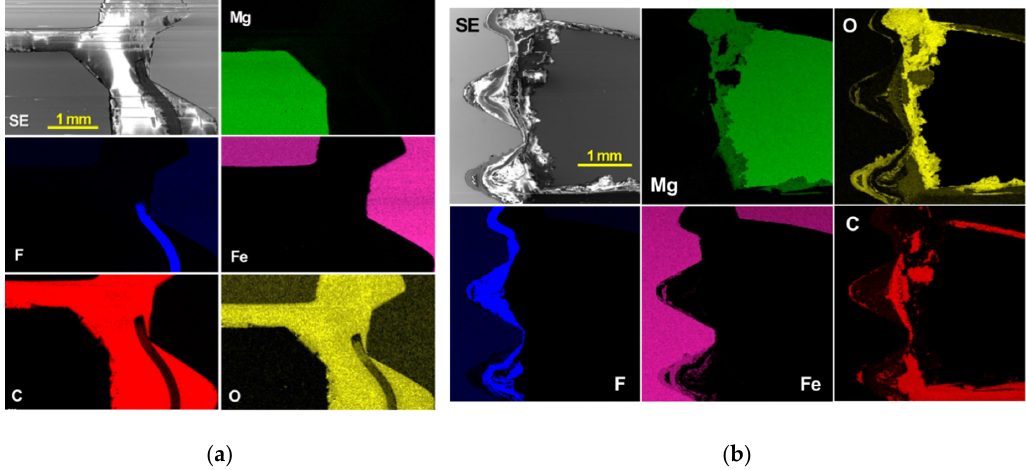
Figure 12. SEM images with corresponding EDS maps for ( a ) the area designated by B in Figure 11a and ( b ) the area designated by E in Figure 11b. All EDS elemental maps were recorded using K-alpha characteristic X-ray of each element.